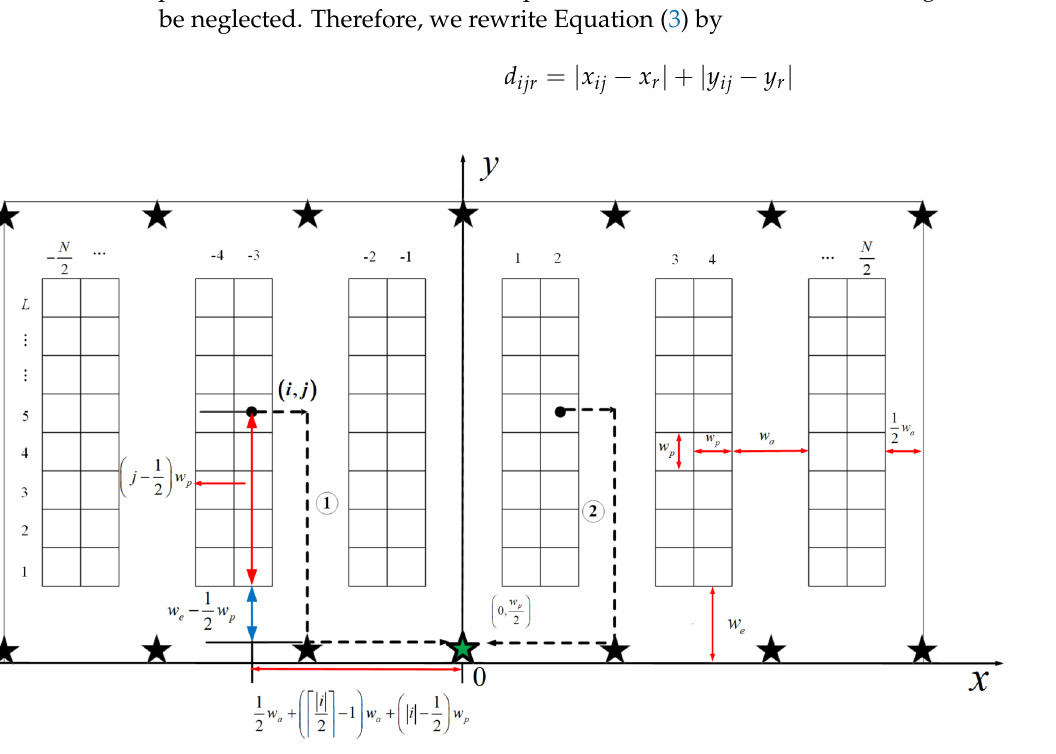
Figure 3. Sketch of a traditional warehouse